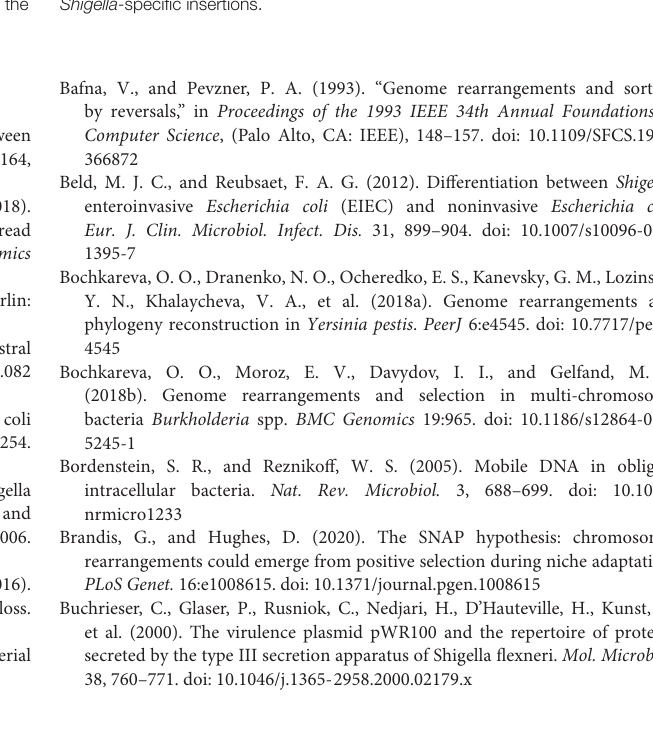
edges of the genome G (right) are shown in red. (b) The breakpoint graph G ( P, Q ) of genomes P and Q . (c) The multiple breakpoint graph of five unichromosomal circular genomes. Supplementary Figure 3 | Chromosome maps. (a) Escherichia coli C4, (b) Escherichia coli cfsan029787, (c) Shigella flexneri 1a 228, (d) Shigella boydii atcc 9210, (e) Shigella dysenteriae sd197, and (f) Shigella sonnei fdaargos 524. The inner circle – GC-skew, the second (blue) circle – synteny blocks, the third (green) circle – universal synteny blocks, the fourth (grey) circle – ISs, and the fifth (grey) circle – density of ISs. Supplementary Figure 4 | Phylogenetic distance versus the number of synteny blocks for each pair of genomes. (a) In phylogroup A, (b) in phylogroup B2, (c) in phylogroup D, (d) in phylogroup F. Each point represents a pair of genomes and is coloured according to the genomes the pair includes. Supplementary Figure 5 | Inversion events reconstructed by the MGRA software. (a) A cladogram with the numbers of inversions shown for each branch. (b) The corresponding phylogenetic tree. Phylogroups are marked with coloured strips, pathogenic strains are shown in different colours. Both trees are unrooted. The trees are also available online (iTOL): https://itol.embl.de/tree/9318063 252480721583313649. Supplementary Figure 6 | Genome sizes in panel (a) Shigella , non-pathogenic E. coli , other pathogenic E. coli , and all E. coli (excluding Shigella spp.). (b) Two most abundant pathovars – ExPEC and STEC, non-pathogenic E. coli and all E. coli (excluding Shigella spp.). (c) Different groups of E. coli . The numbers above boxplots indicate the number of genomes in each group. The Wilcoxon–Mann–Whitney test with the Bonferroni correction: ∗ p ≤ 0.05;